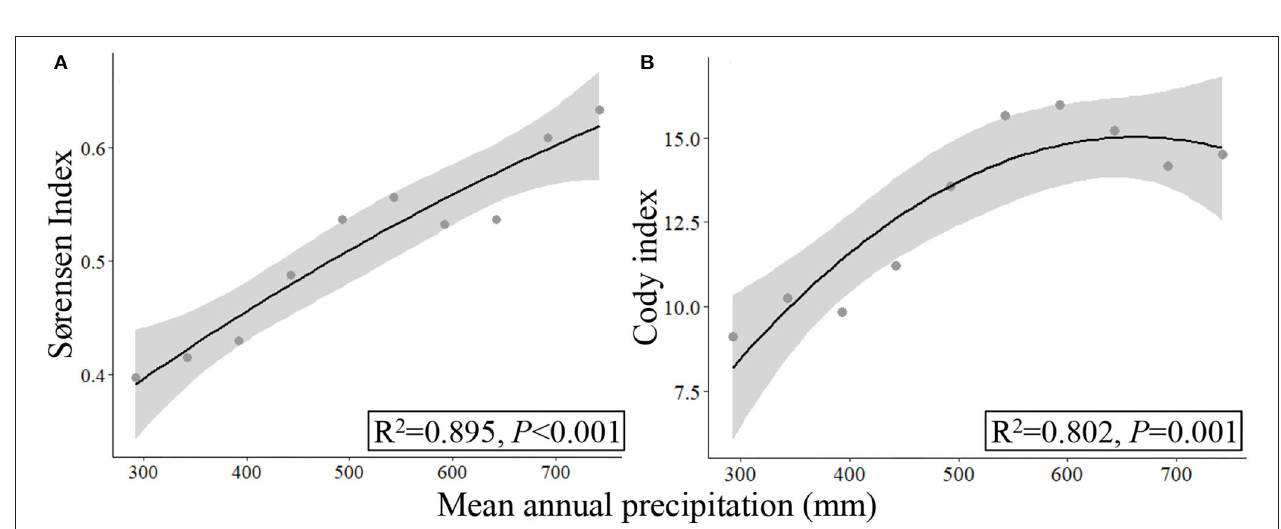
FIGURE 7 | Responses of β -diversity (A,B) to mean annual precipitation (2000–2017) based on the data collected by UAV B .